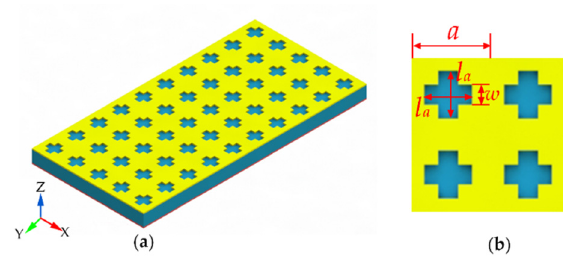
Figure 8. ( a ) Overview and ( b ) top view of the MIM structure with a cross-shape aperture array.